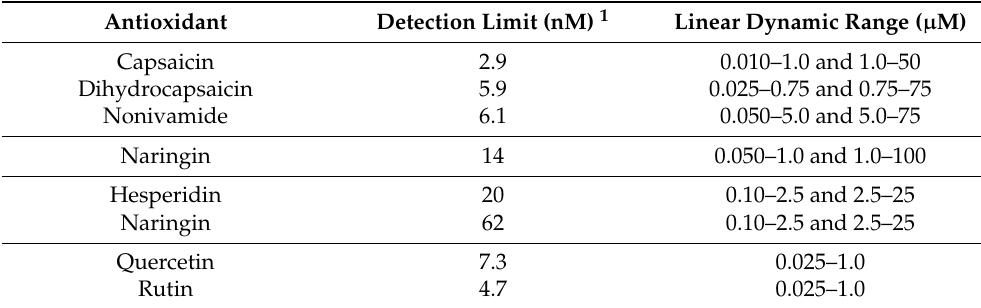
Table 4. Analytical characteristics of natural antioxidant determination using polymer-based sensors. Antioxidant